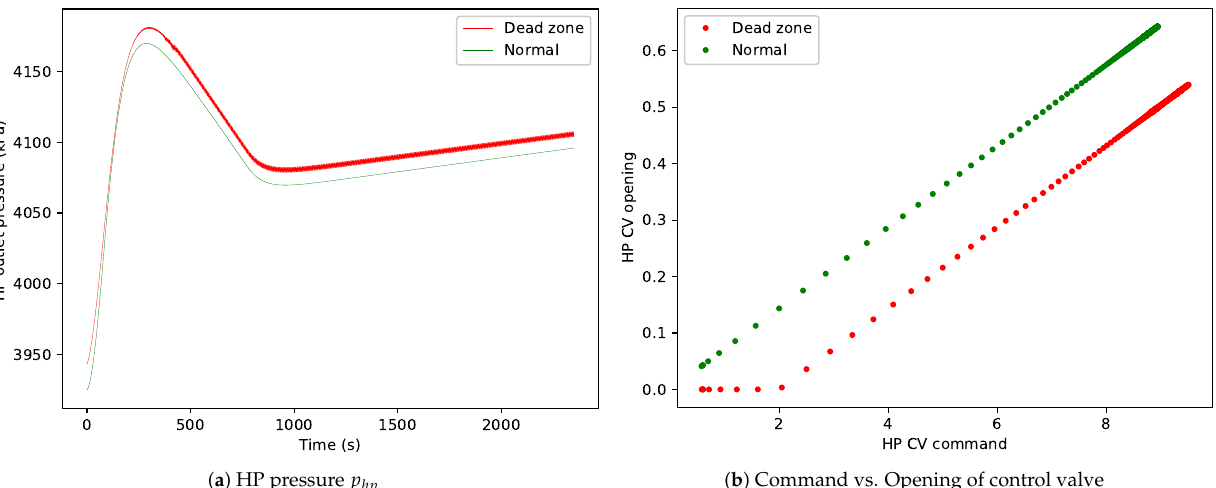
in Figure 4. Figure 4a shows the inlet pressure of HP in the process of turbine power regulation. The inlet pressure of HP is nearly stable at 4100 kPa. It can be inferred that the control valve dead zone does cause the HP oscillation. To some extent, the HP oscillation will lead to system oscillation, which will affect the safe and stable operation of steam turbine.